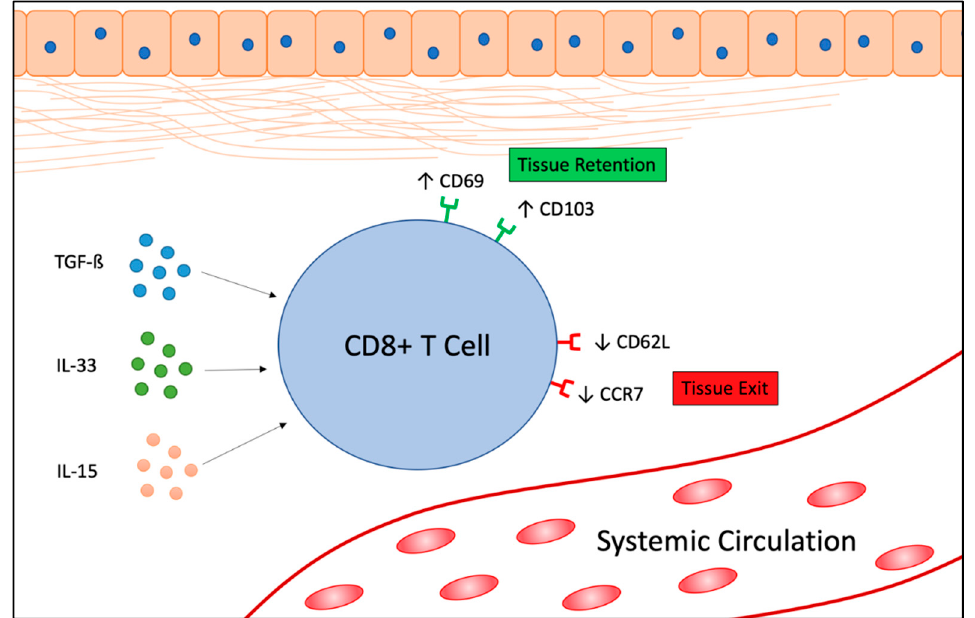
Figure 1. CD8 + T cells enter tissues and are stimulated by TGF-ß, IL-33, and IL-15 to upregulate the tissue-retention surface markers, CD69 and CD103, while simultaneously down-regulating the tissue- egress markers, CD62L and CCR7. This creates a resident memory T (T RM ) cell phenotype, enabling T RM cells to maintain close contact with malignant cells residing within